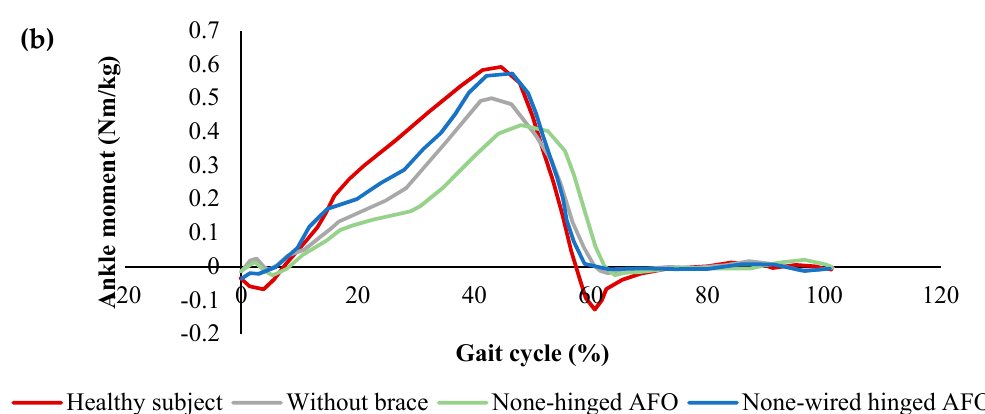
Figure 19. ( a ) Ankle angle variation, and ( b ) ankle moment variation over the gait cycle for the healthy subject drop foot patient with and without AFO [49].